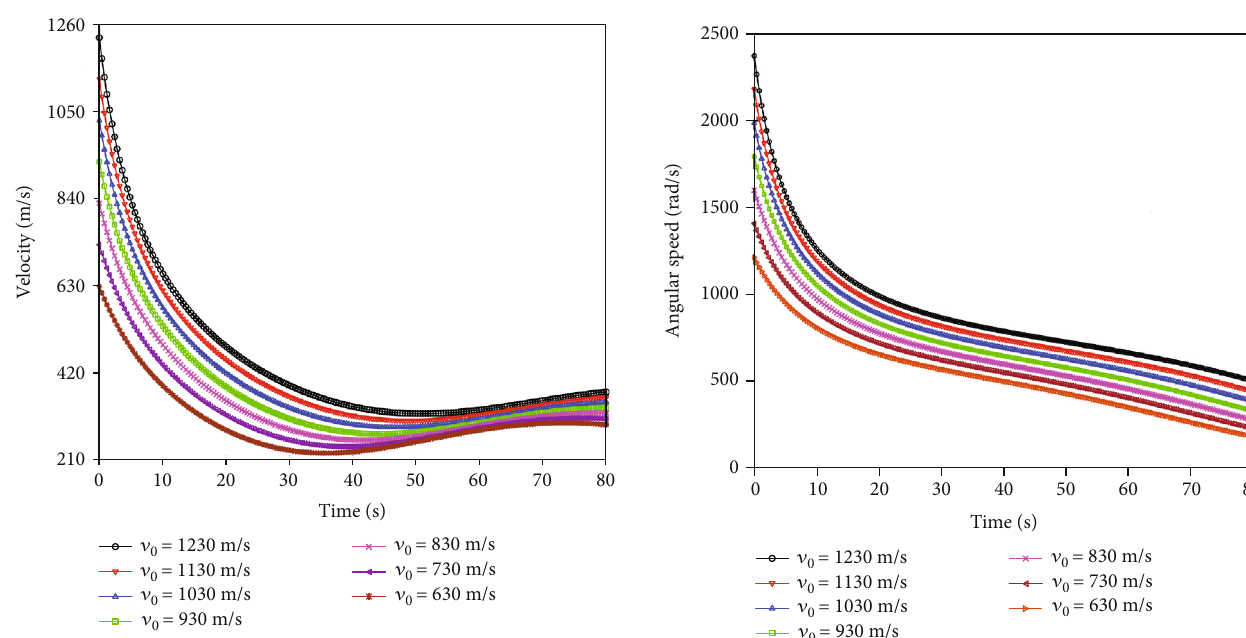
Figure 4: Angular speed at di ff erent initial velocities.